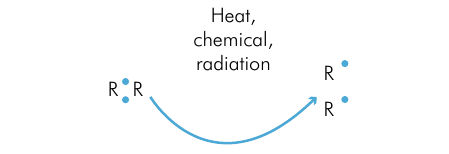
Figure 2. Schematic illustration of external energy factors acting on a radical-generating species to result in formation of “free radicals”. Figure 3. Diagram of the polymerization initiation